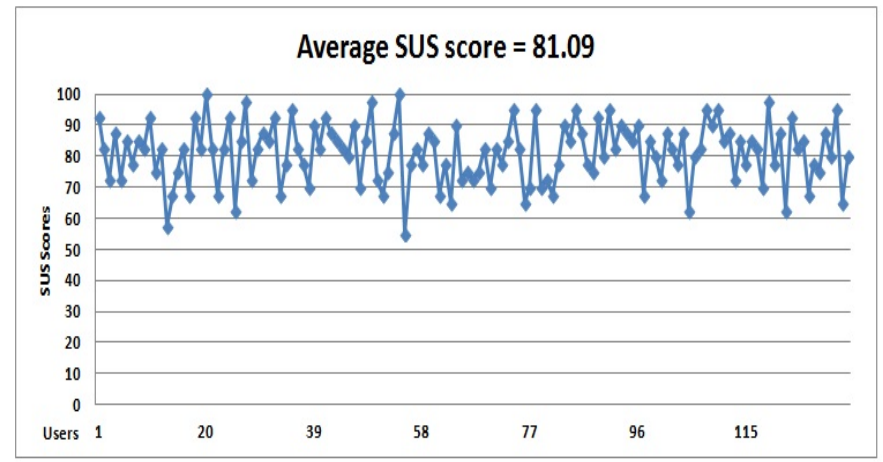
Figure 13. The SUS score of the IIoTMS.